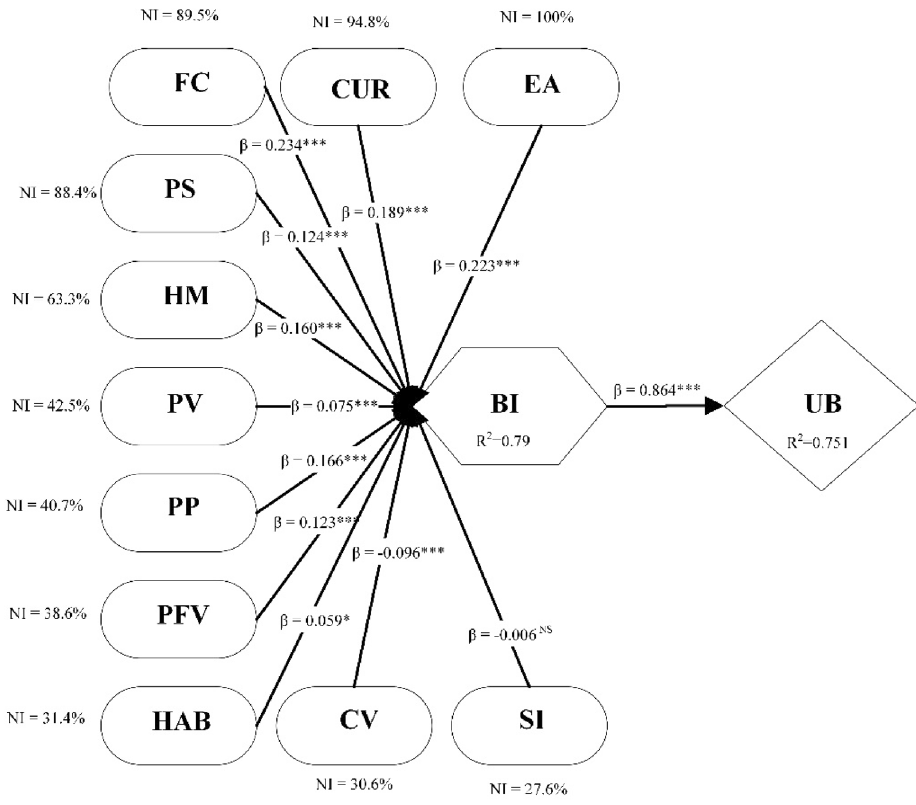
Figure 5. SEM-ANN results. Note: PP = Perceived Performance; PFV = Perceived Functional Value; PV = Perceived Value; PS = Perceived Satisfaction; HAB = Habit; HM = Hedonic Motivation; CUR = Curiosity; SI = Social Influence; EA = Environmental Awareness; FC = Facilitating Condition; CV = Cost Value. NI = normalized importance from ANN sensitivity analysis, β = Coefficients from SEM; R 2 = Calculated in